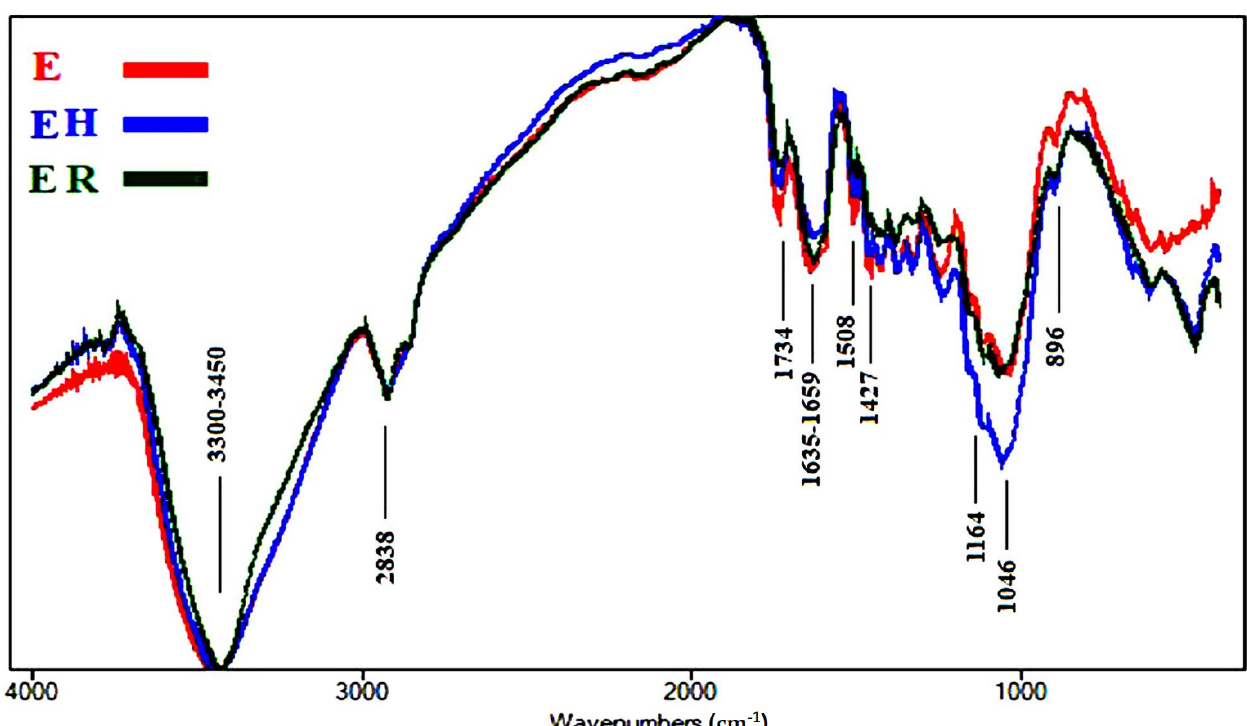
Figure 8. FTIR spectra of the wood sample of Juglans nigra (E, control; EH, heated ageing; ER, rusted ageing).